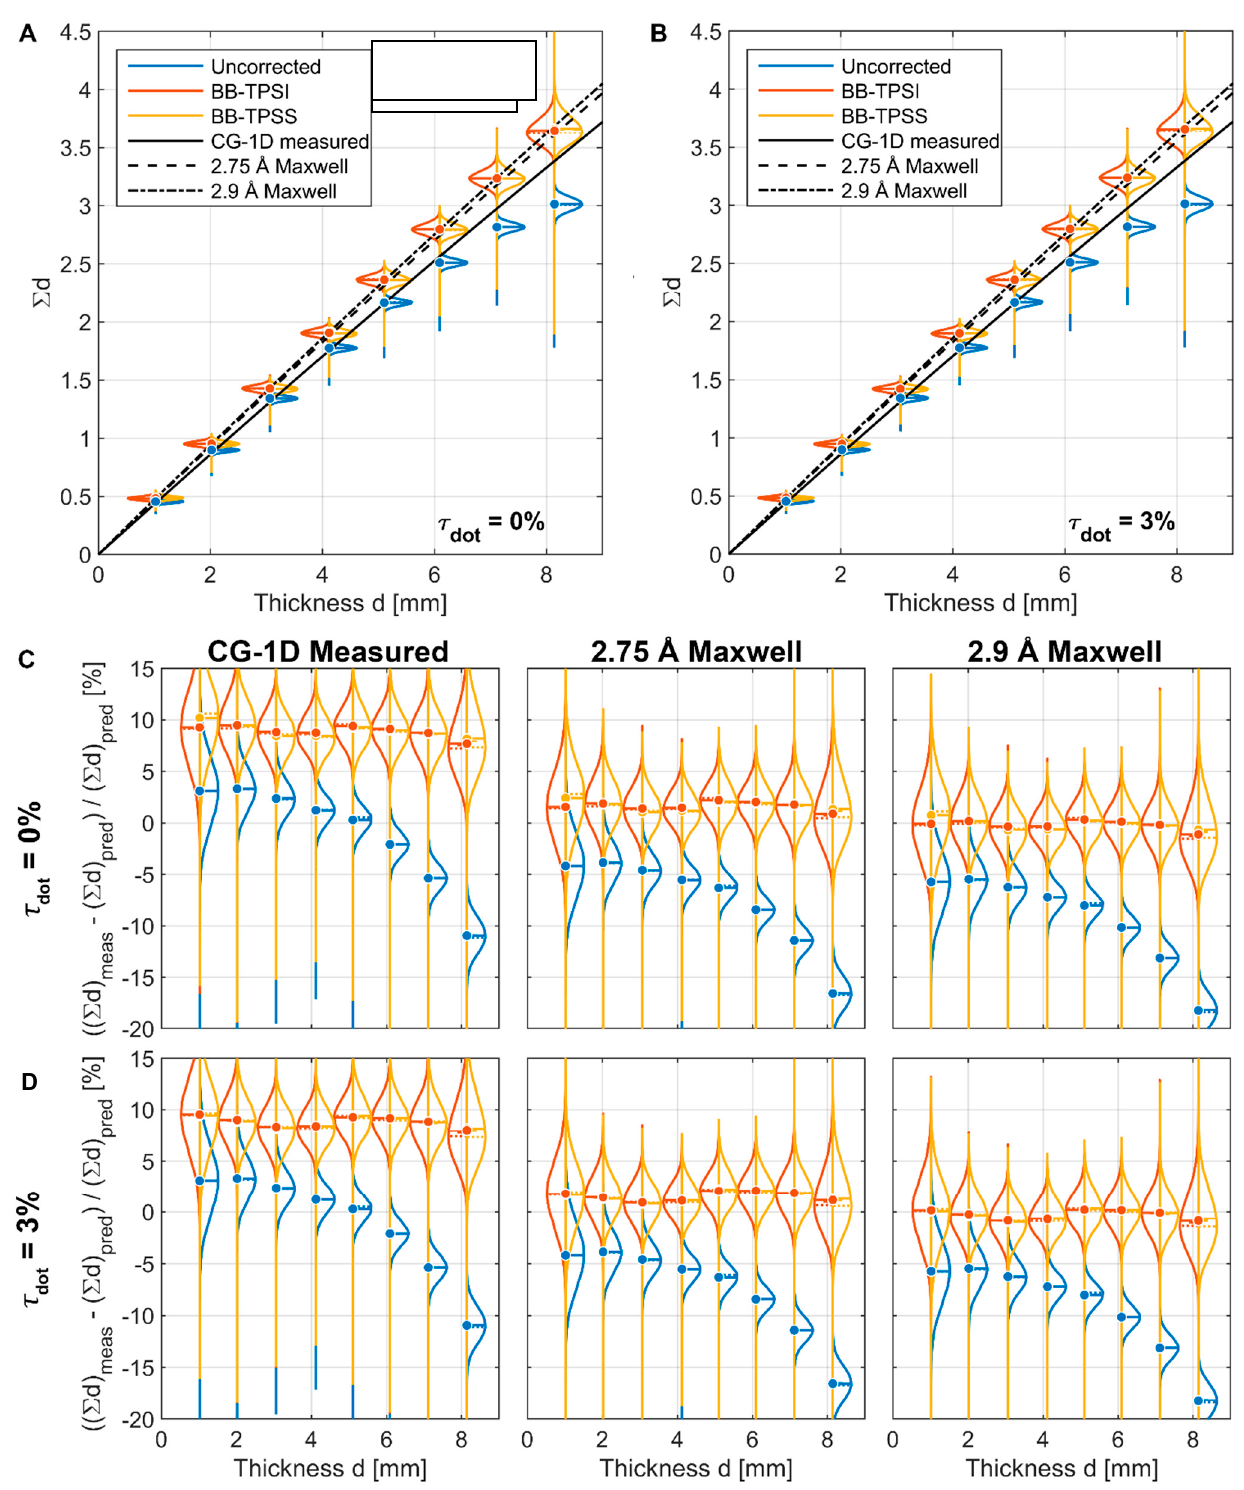
Figure 14. Comparison of BB scattering corrections for PMMA step wedge measured at CG-1D against predicted values of 𝛴𝑑 using known cross sections [17] and the CG-1D spectrum as measured in 2010 and 2.75 Å and 2.9 Å Maxwell–Boltzmann spectra. ( A ) Values of 𝛴𝑑 assuming 0% BB transparency. ( B ) Values of 𝛴𝑑 assuming 3% BB transparency. ( C ). Relative 𝛴𝑑 error assuming 0% BB transparency. (D ). Relative 𝛴𝑑 error assuming 3% BB transparency.